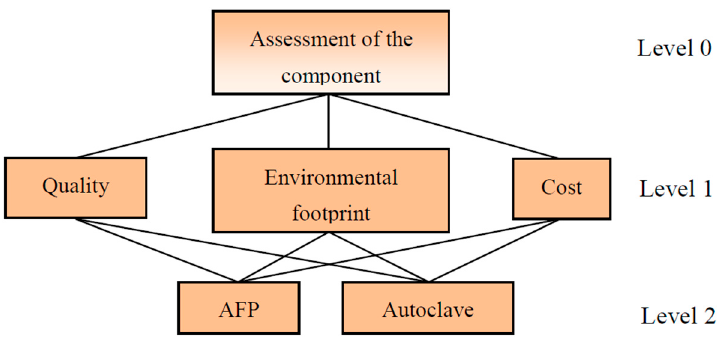
Figure 9. AHP network for the fuselage panel production.